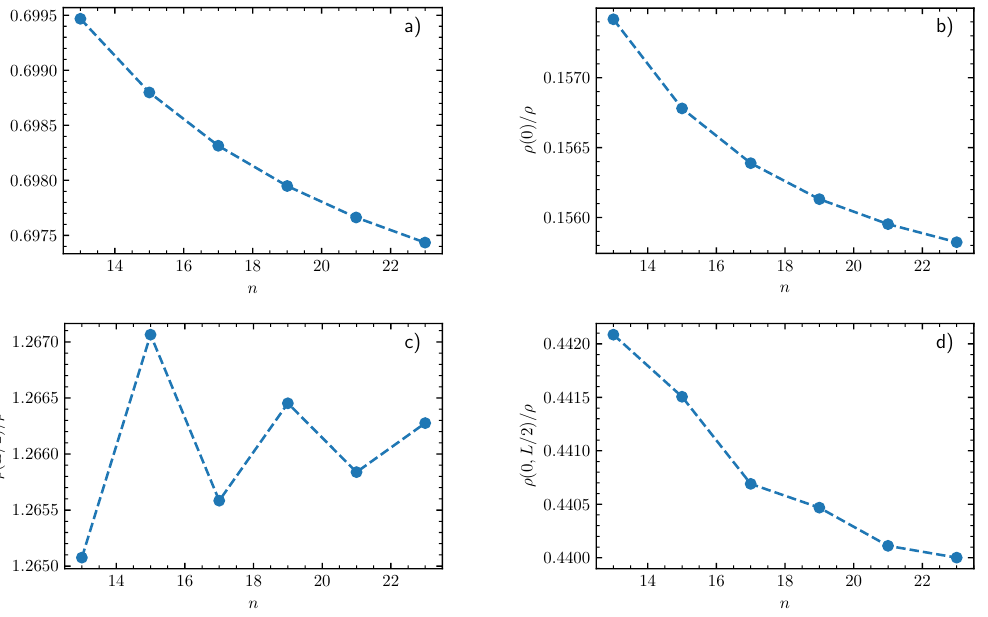
Figure 14: Convergence of observables for a system with one repulsive impurity as a function of the truncation parameter, n . The parameters of the system are N = 50, γ = 0.02 and c = 0.5. Panel a) shows the energy of the system, panel b) presents the density at z = 0, panel c) shows the density at z = N / 2, and panel d) gives the one-body density matrix at ρ ( 0, N / 2 ) . The dashed curves are added to guide the